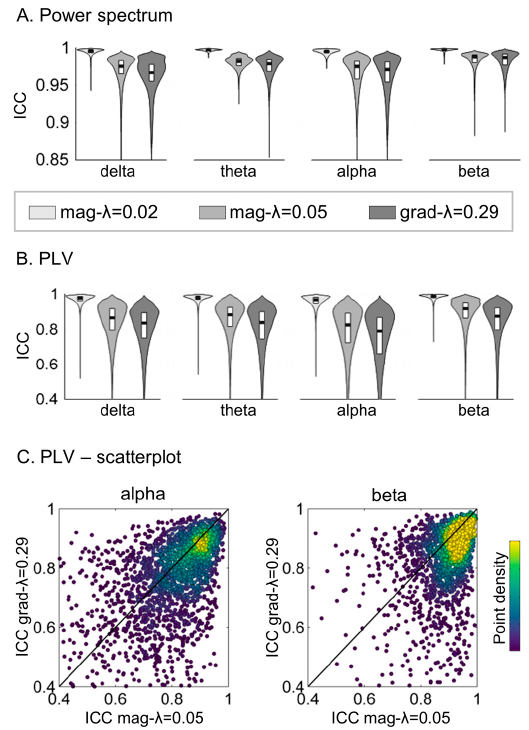
Figure 4. Inter-pipeline reliability of power spectrum and phase locking value (PLV) estimates. The